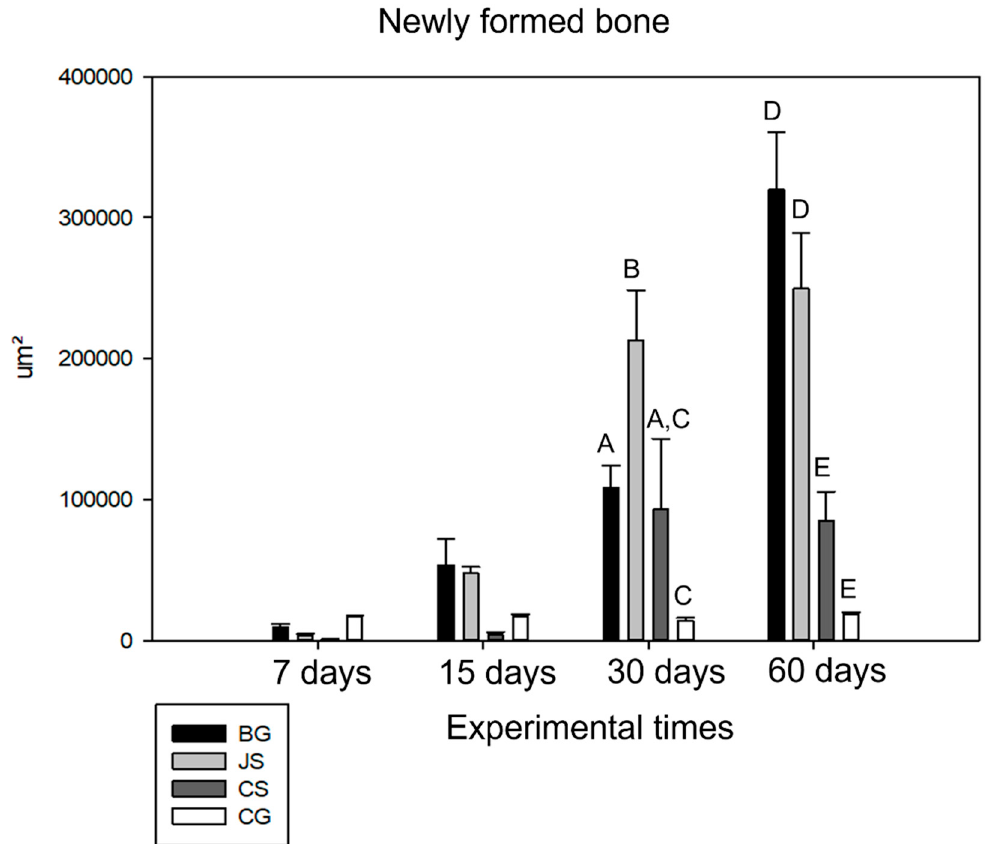
Figure 6. Comparative graph of the means and standard deviation of the neoformed bone area of all groups (BG, JS, CS, and CG) for the experimental times of 7, 15, 30, and 60 days. Capital letters show a statistically significant difference between groups for the periods of 30 and 60 days, in the periods of 7 and 15 days, there was no statistical difference between the groups analyzed.